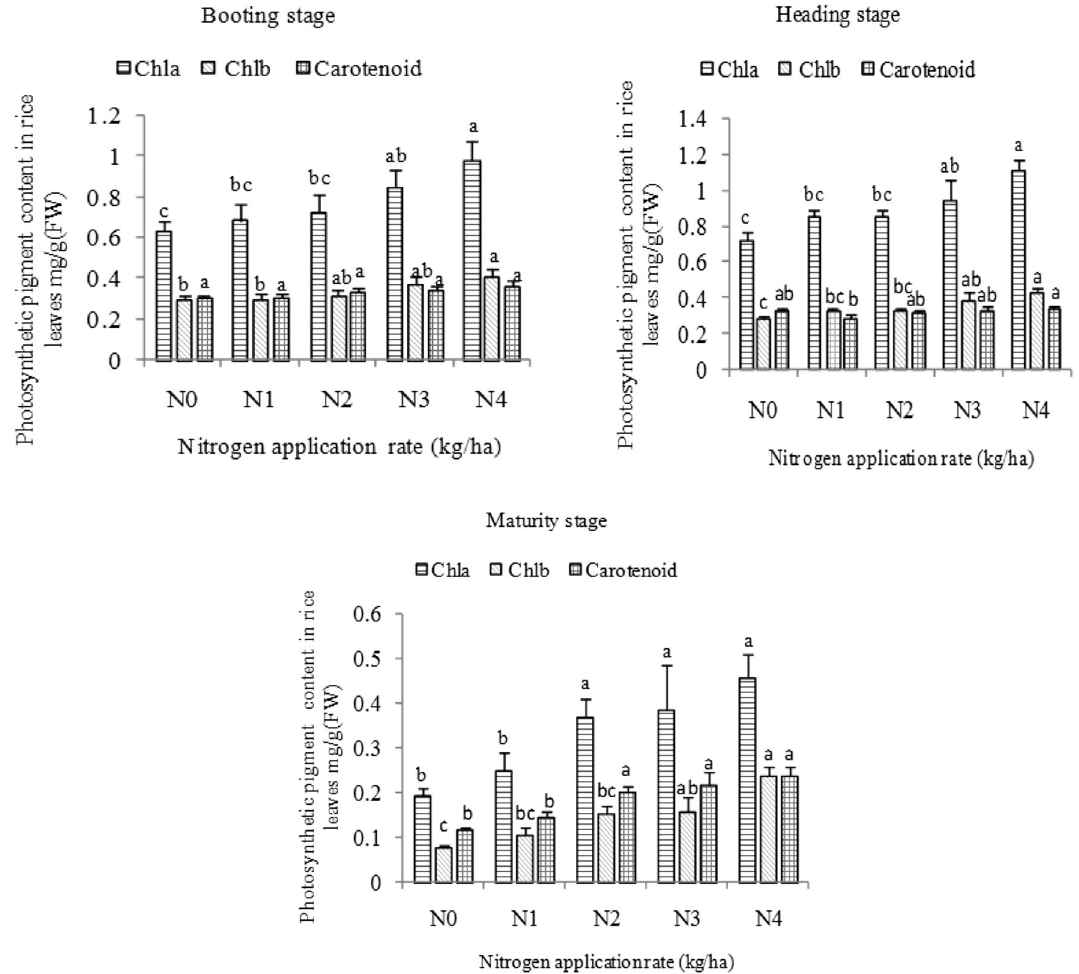
Figure 1. Effects of different nitrogen application rates on photosynthetic pigments in rice leaves. Note N0:0 kg ha -1 ; N1:75 kg ha -1 ; N2:150 kg ha -1 ; N3: 225 kg ha -1 ; N4:300 kg ha -1 ; Chla, chlorophyll ( a ); Chlb, chlorophyll ( b ); significant differences between rice varieties and nitrogen treatments ( P < 0.05) are indicated by lowercase letters; vertical bars represent SE (n = 3). The data in the figure is the average value of the two